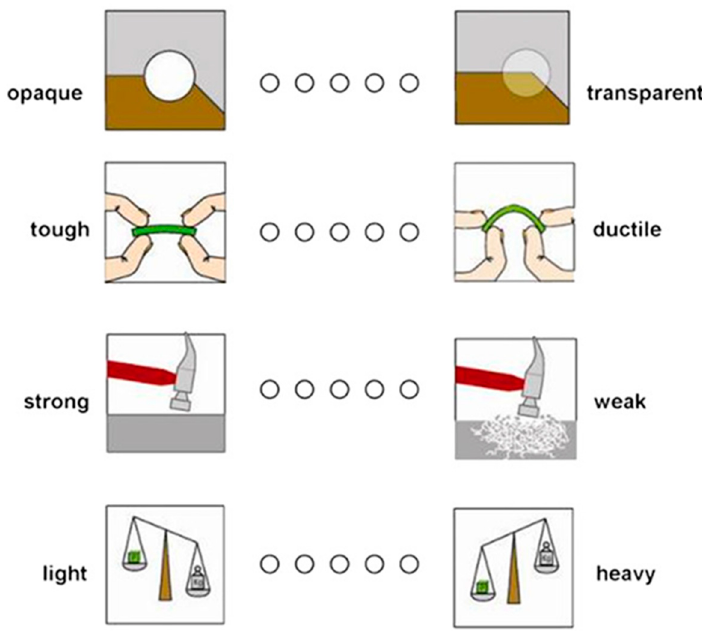
Figure 2. Material characteristics [33]. (Copyright 2012 Elsevier).